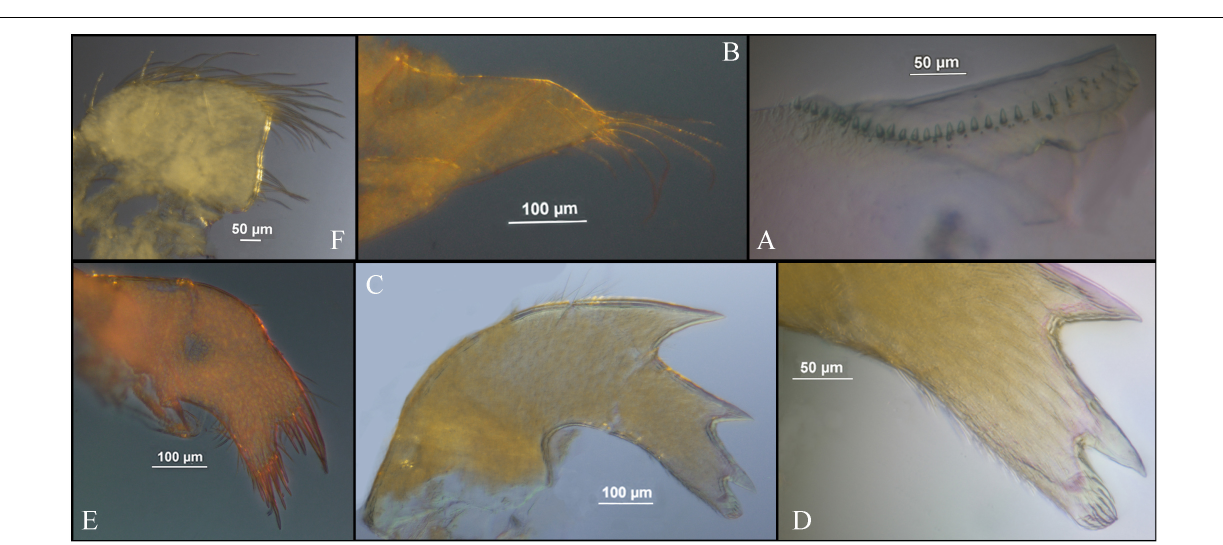
rami nearly equal, each rami segment armed with three pairs of long setae and one pair of proximal short setae on inner edge with one pair of setae on outer margin of joint ( Figures 4E–I ). absent ( Figure 4J